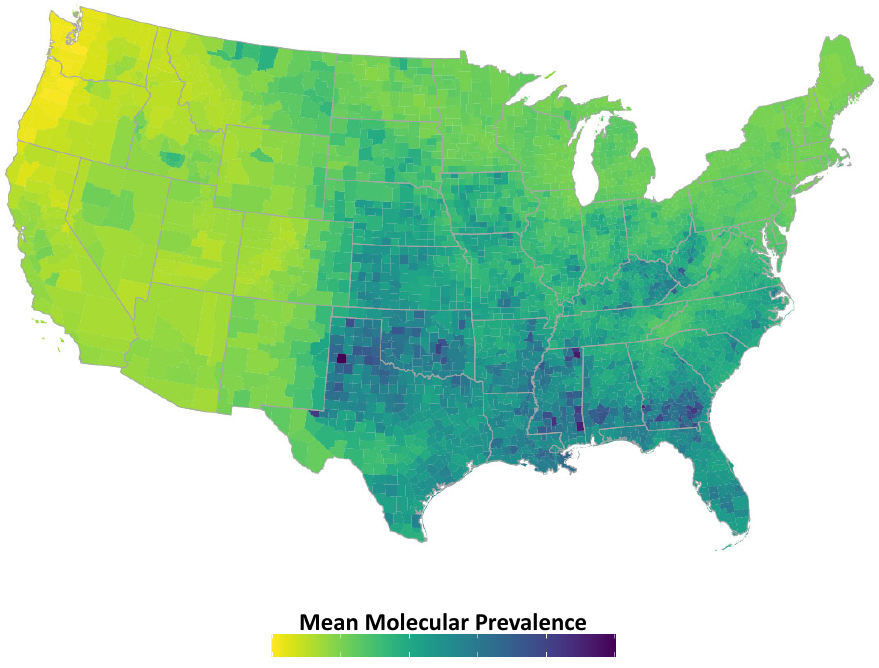
Figure A15. Static avian WNV mean molecular prevalence. Molecular prevalence covariate under assumption of a static species pool (May–August). Covariate reflects avian community average WNV prevalence based on estimates reported by Tolsá et al. [54]. Mapped counties are color coded according to legend at bottom to indicate increased WNV prevalence with darker